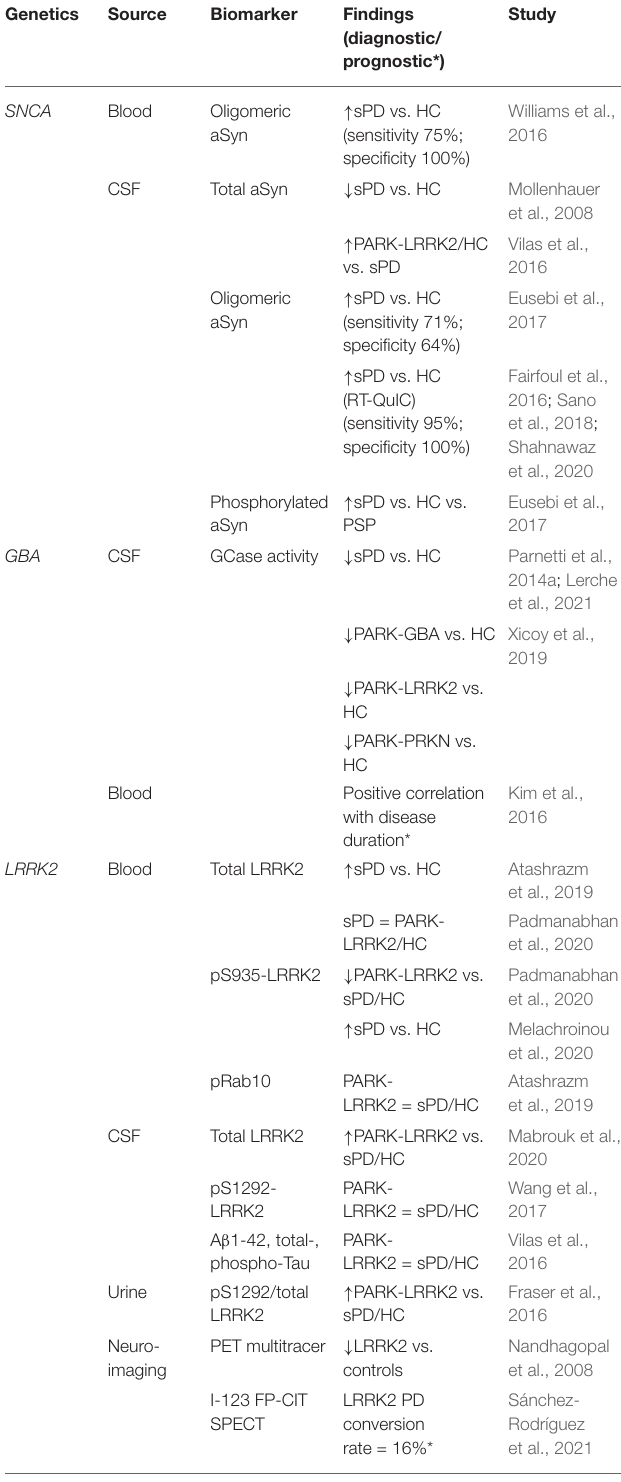
TABLE 1 | An overview of the genetic causes of Parkinson’s disease (PD), the corresponding biomarker, and the diagnostic and/or prognostic